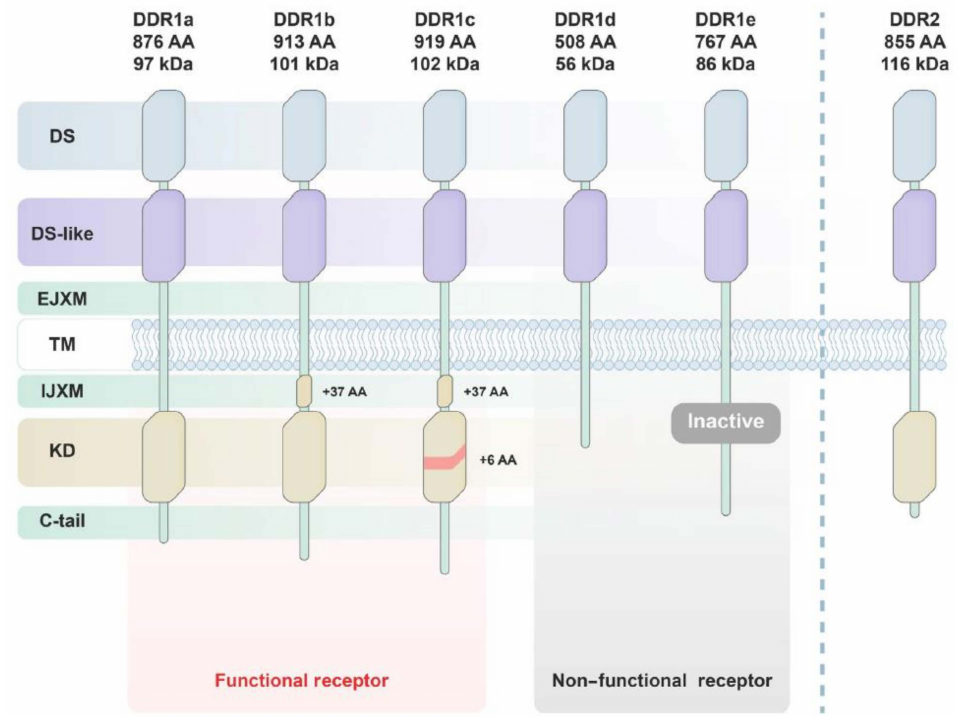
Figure 1. Structures and subtypes of DDR1 and DDR2. Reprinted from with permission Ref.